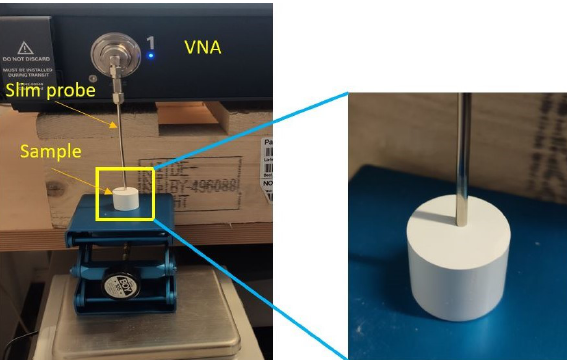
Figure 1. Dielectric properties measurement set-up. The Keysight slim probe is placed on the sample after a full one-port